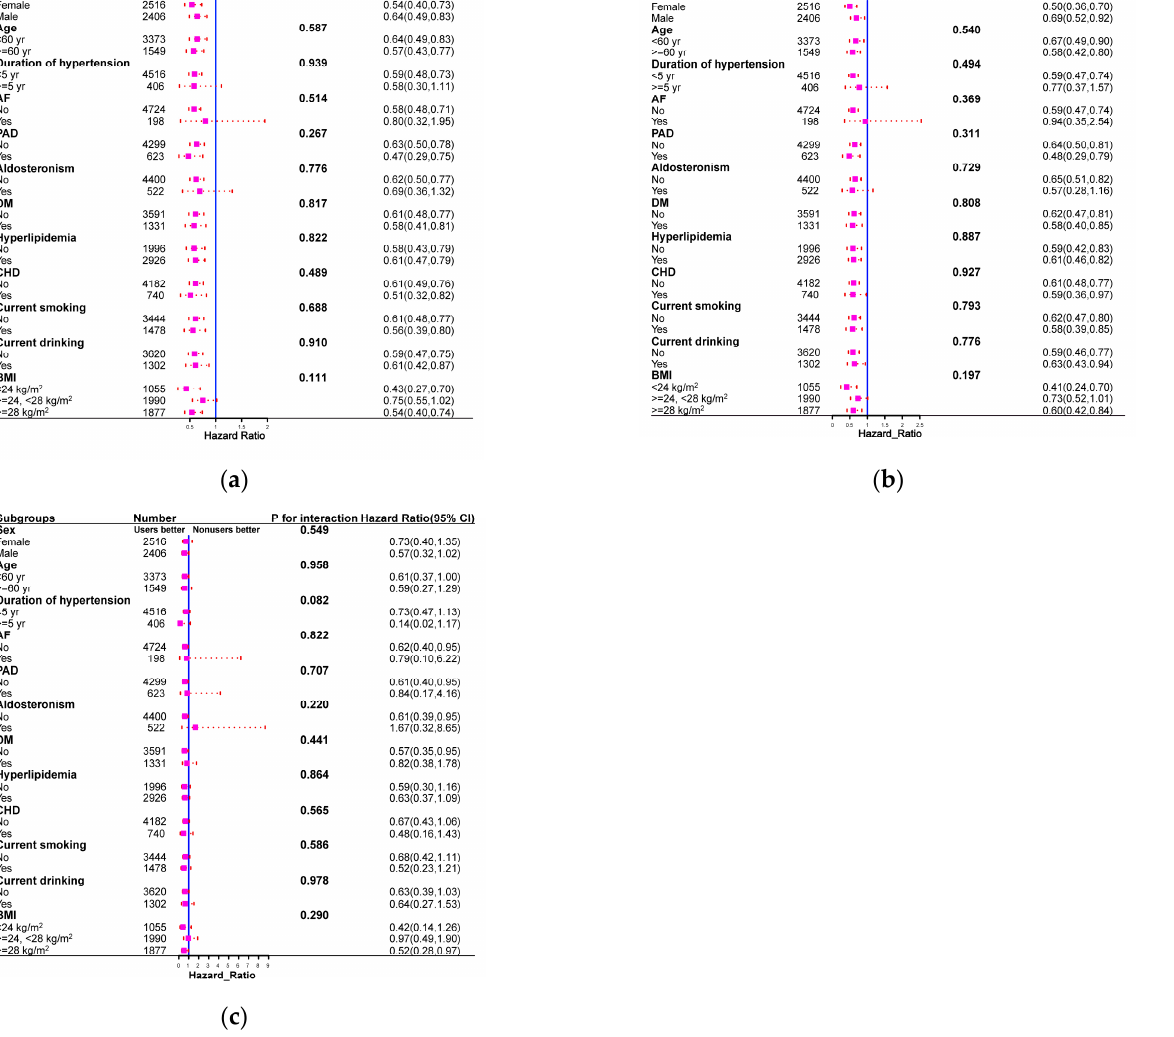
Figure 3. Subgroup analysis comparing spironolactone users with non-users in terms of the risks of total stroke ( a ), ischemic stroke ( b ), and hemorrhagic stroke ( c ) in propensity-score-matched cohort. 2.5. Dose and Cumulative Duration of Spironolactone Use and the Risk of Outcome Events